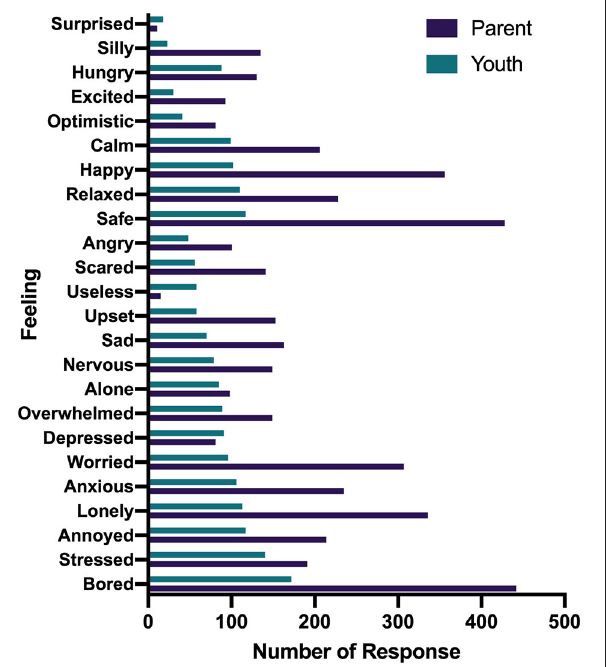
TABLE 1 | Parent and youth